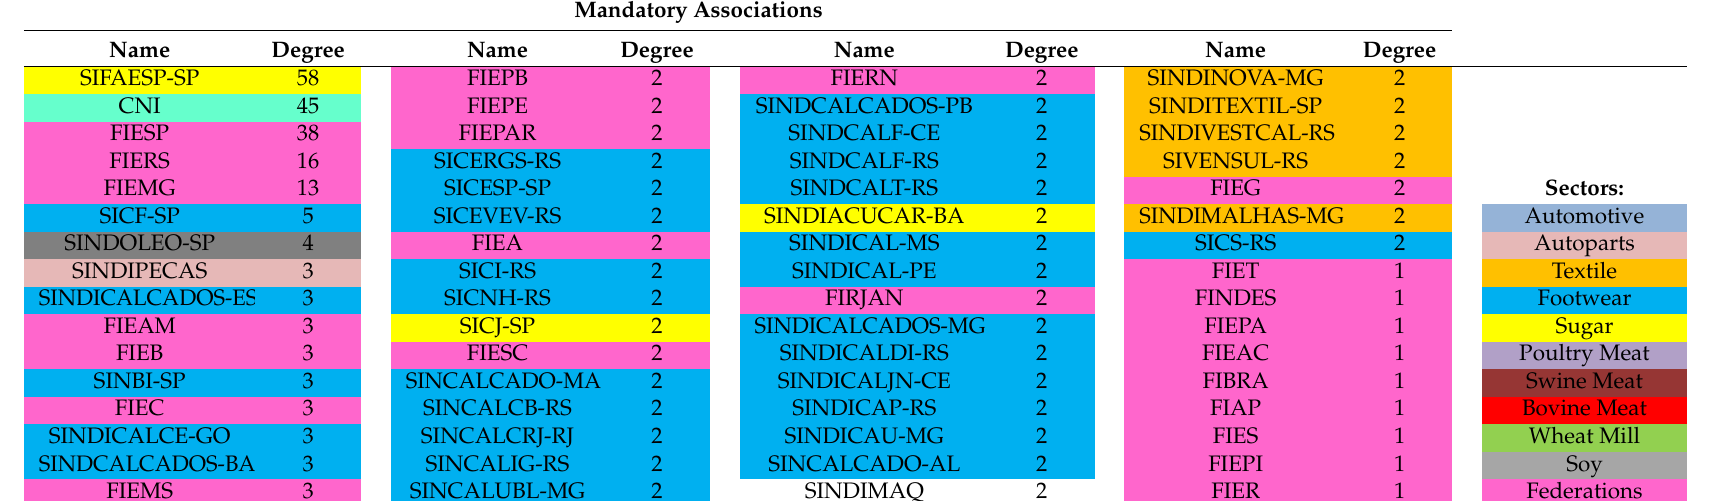
Table A2. Compulsory associations’ degree centralities by economic subsector.